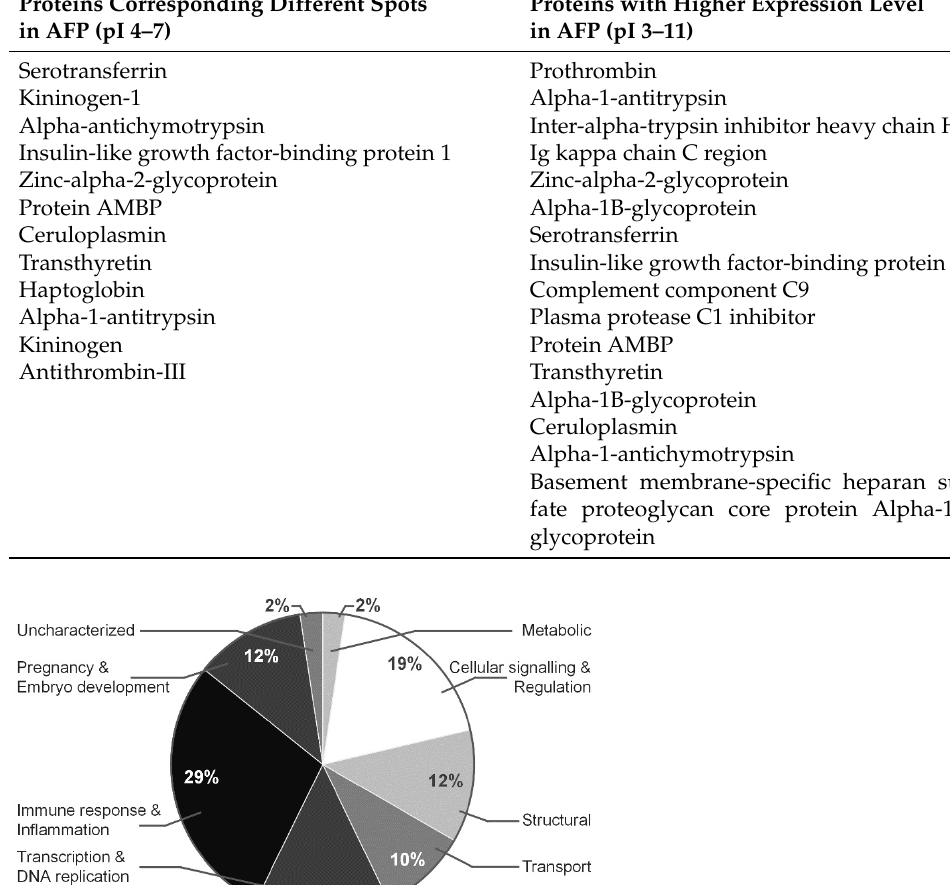
Table 3. Identified AFP proteins—those expressions are higher in comparison to proteome associated with normal pregnancy in 2DE gels with pI 3–11 ranges (right panel) and AFP proteins, the spots number of which (proportionate to modification) in AFP pI 4–7 differ in comparison to fractionated in pI 3–11 range (left panel).